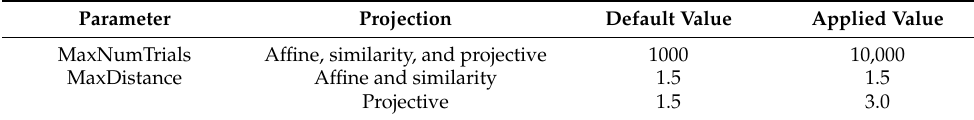
Table 4. Default and applied values of two parameters of the estimateGeometricTransform function used in this study. Parameter Projection Default Value Applied Value MaxNumTrials Affine, similarity, and projective